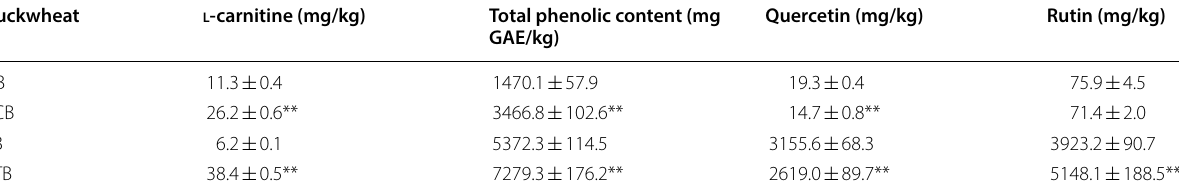
Table 2 l -carnitine, total phenolic content, quercetin and rutin concentration in buckwheat after R. oligosporus fermentation